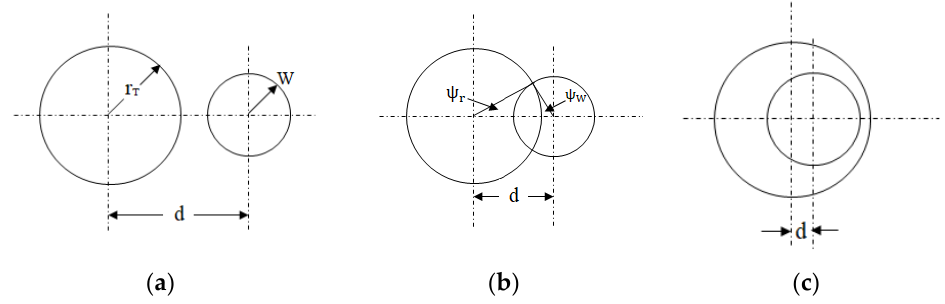
Figure 2. Three cases of overlapping between the telescope field-of-view and a laser beam for a biaxial lidar: ( a ) no overlap; ( b ) partial overlapping; ( c ) complete overlapping (r T is the radius of the circular field of view; W is the radius of the circular region of laser illumination).